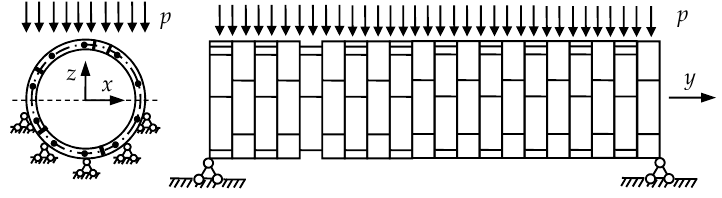
Figure 9. The boundary conditions and uniform load applied to the model.